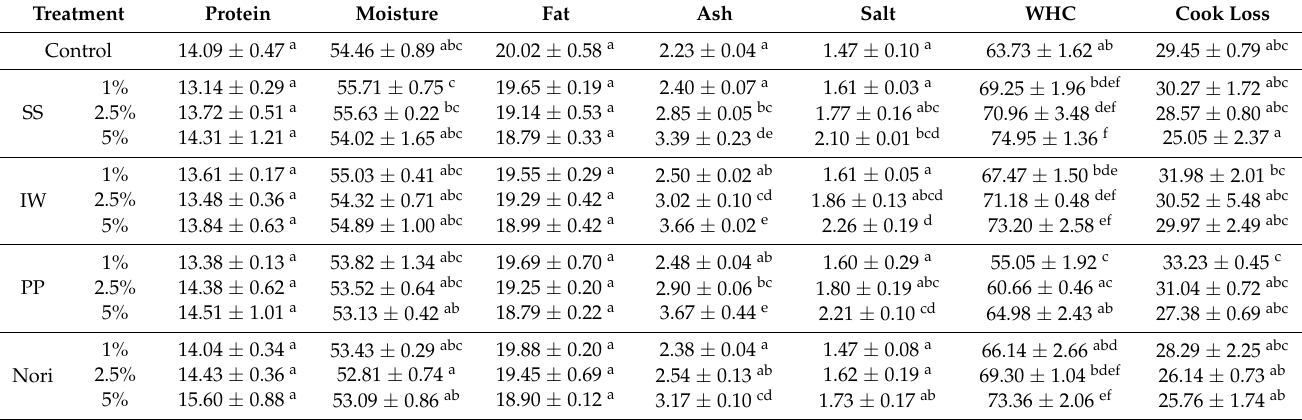
Table 2. Proximate composition, salt, WHC, and cook loss of control sausage and sausages containing 1%, 2.5%, and 5% brown and red seaweed